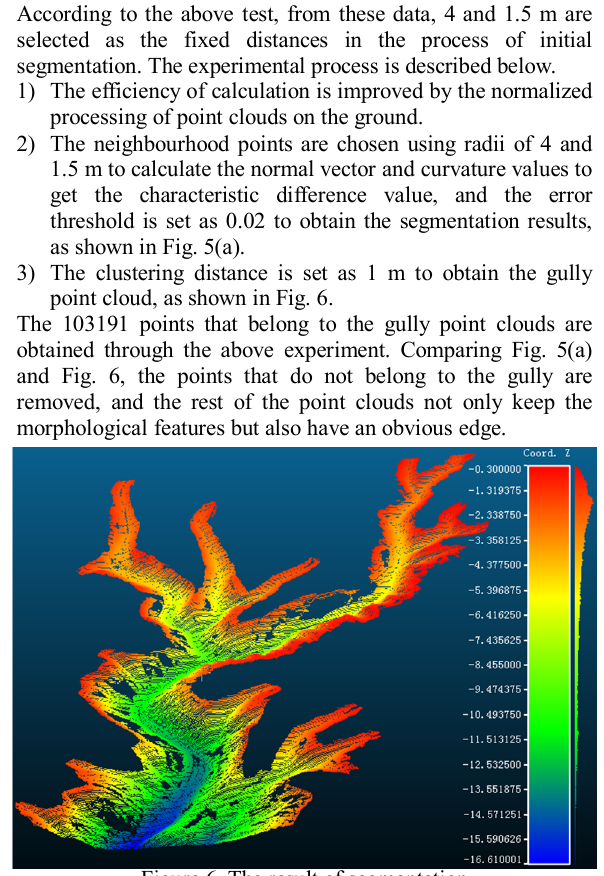
Figure 6. The result of segmentation